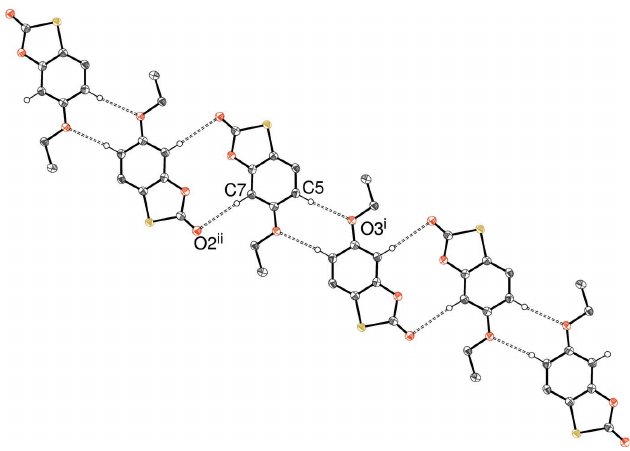
Figure 3 Fragment of a [111] hydrogen-bonded chain in (I); all hydrogen atoms except H5 and H7 have been omitted for clarity. Symmetry codes as in Table 1.